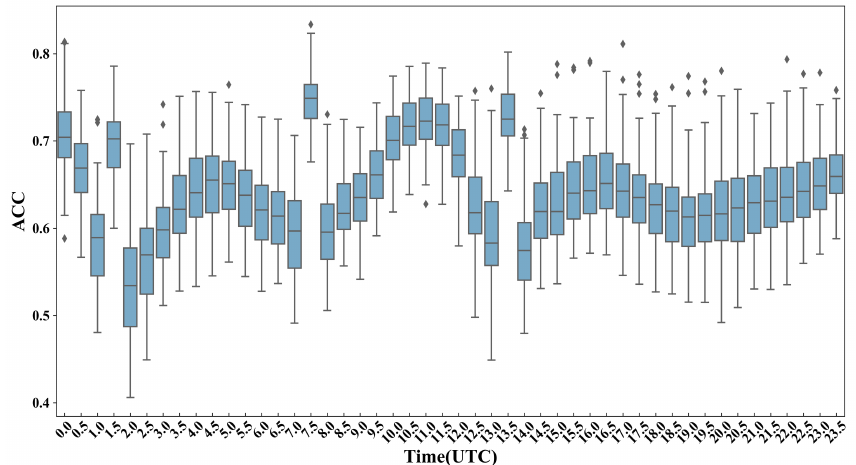
Figure 13. The diurnal variation of ACC for the precipitation grades’ estimation in testing dataset in summer 2019; the distributions of the statistical values by half-an-hour are interpreted in box plots. Box diagrams indicate the 25th, 50th, and 75th percentiles, whereas the periphery of the box extends to 1.5-times the quartile deviation (25th–75th percentile). Outliers are indicated by black